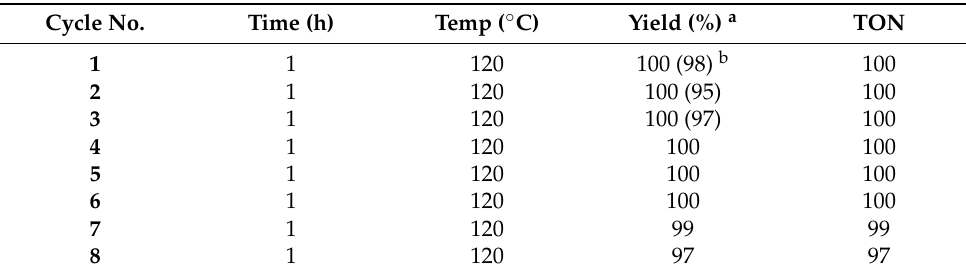
Table 3. Recycling results of 2a -catalyzed Stille reaction of 4-nitroiodobenzene ( 6 ) and vinyl tributyltin ( 3 ) under the thermomorphic mode.